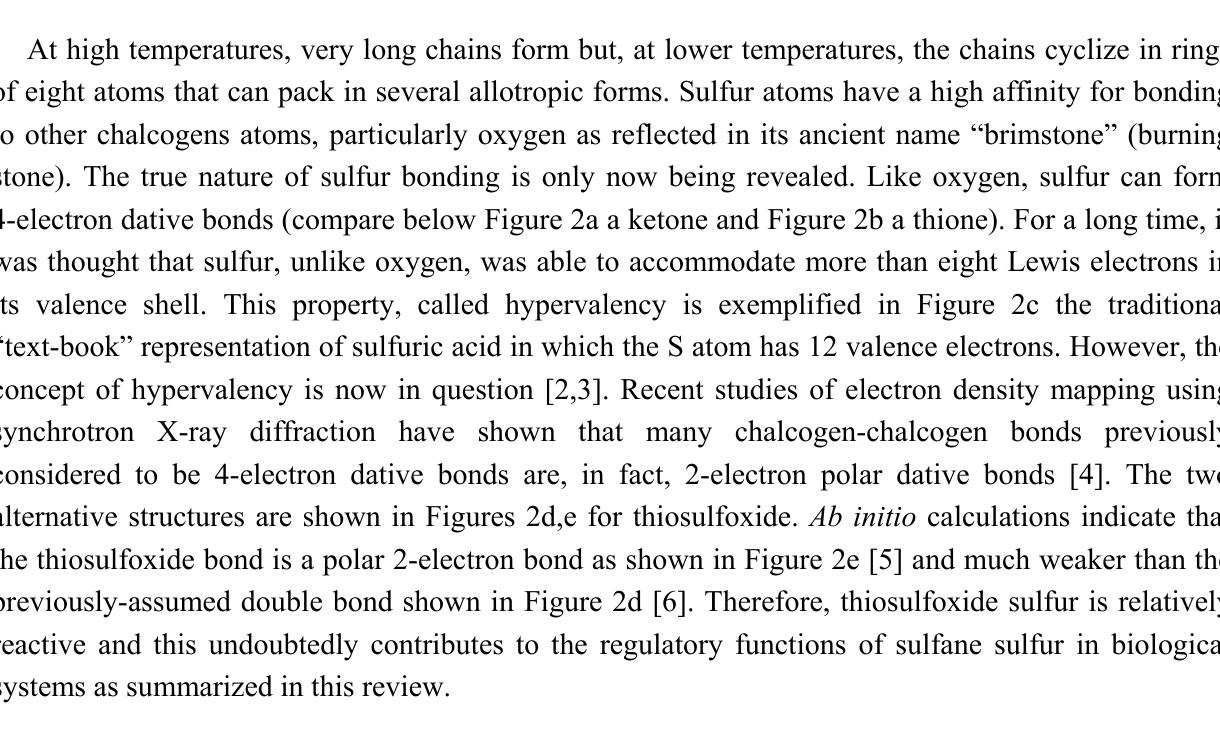
Figure 1. Bonding of elemental dulfur.